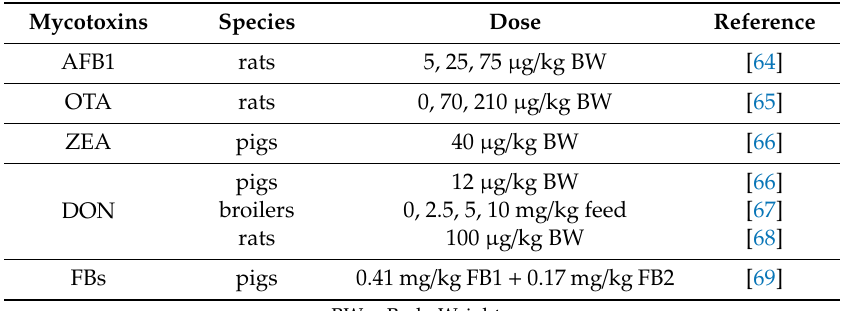
Table 6. In vivo studies on the e ff ects of di ff erent mycotoxins on intestinal mucosal biological barriers in di ff erent